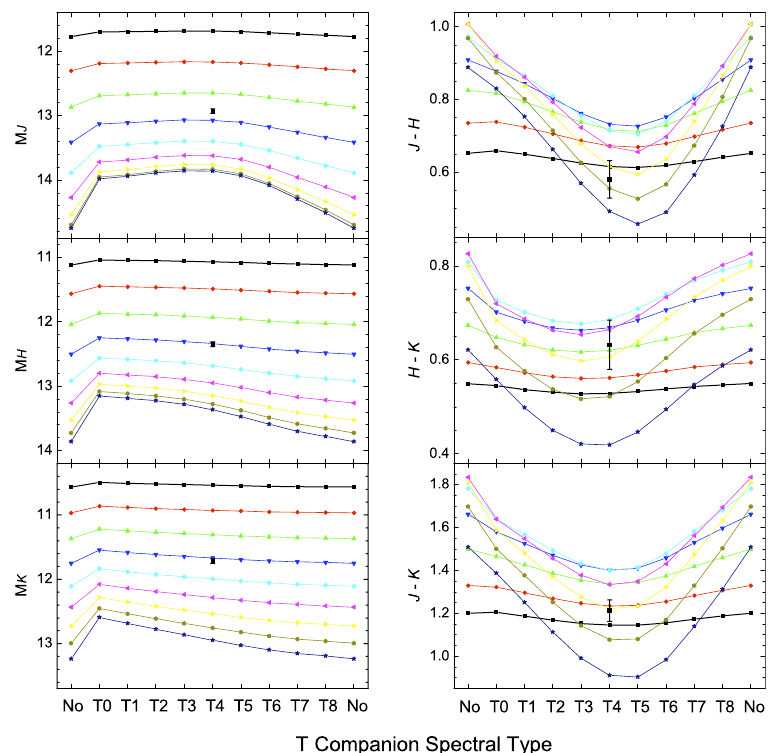
Figure 3. JHK absolute magnitudes and colors of unresolved L + T binaries. Different lines represent absolute magnitudes and colors of L dwarf primaries (L1–L9, from top to bottom in left panel) without or with different T companions (T0–T8). If (cid:1) Cancri B ( black square ) is actually an unresolved binary, then the constituents would likely be made up of an L4 + a T4